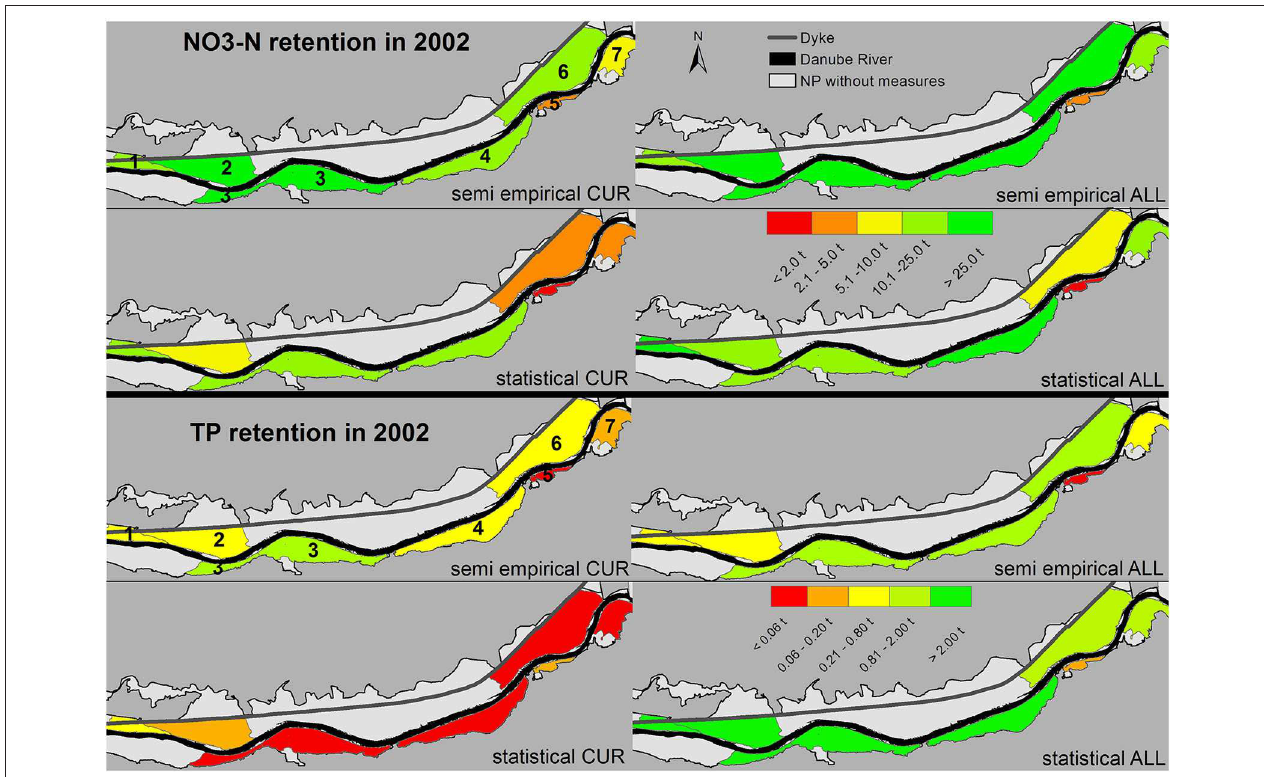
FIGURE 6 | Contribution of each side arm system to NO 3 -N and TP retention in the wet year 2002 for the scenarios CUR and ALL. Numbers are given instead of side arm system names and explained in the text.